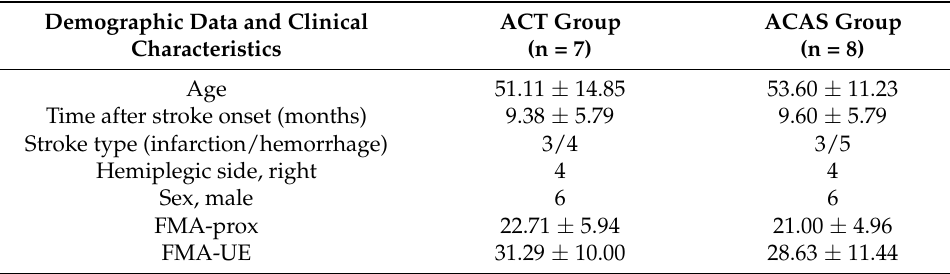
Table 2. Baseline characteristics of the